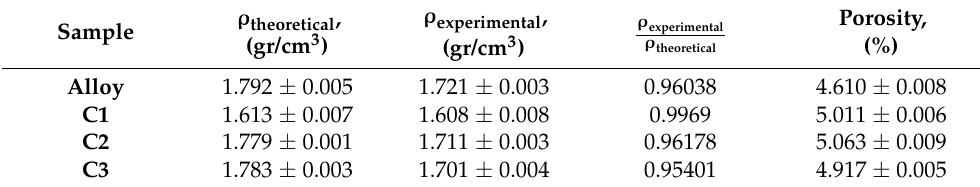
Figure 1. The schematic route for fabricating composites. Table 1. The theoretical and experimental values of density and porosity.